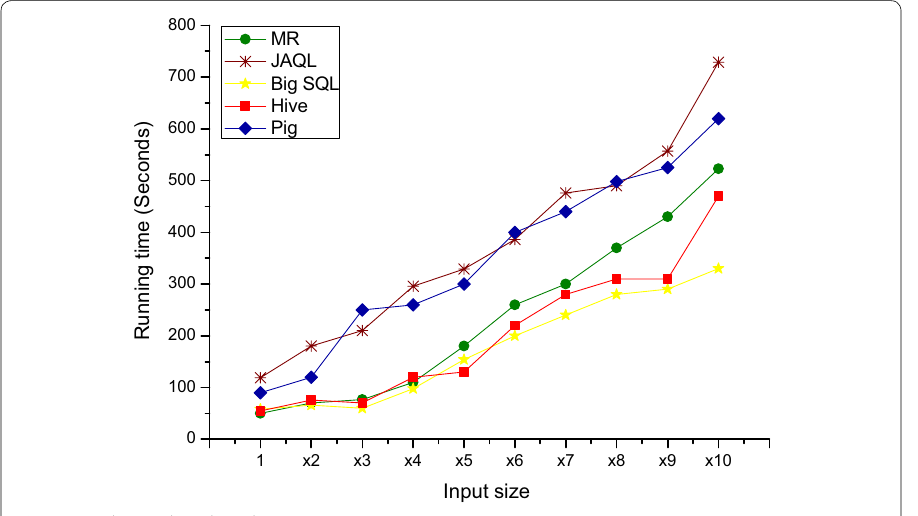
Fig. 8 WordCount benchmark metric in increasing input